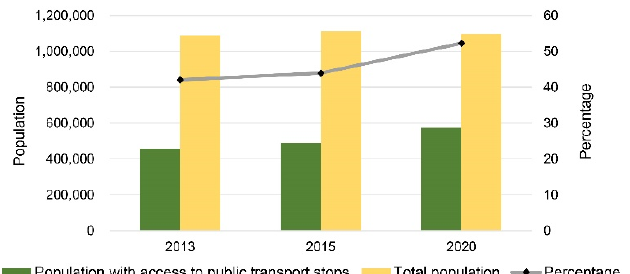
Figure 4. Number and percentage of the population with access to public transport stops from 2013 to 2020 in Guilin.